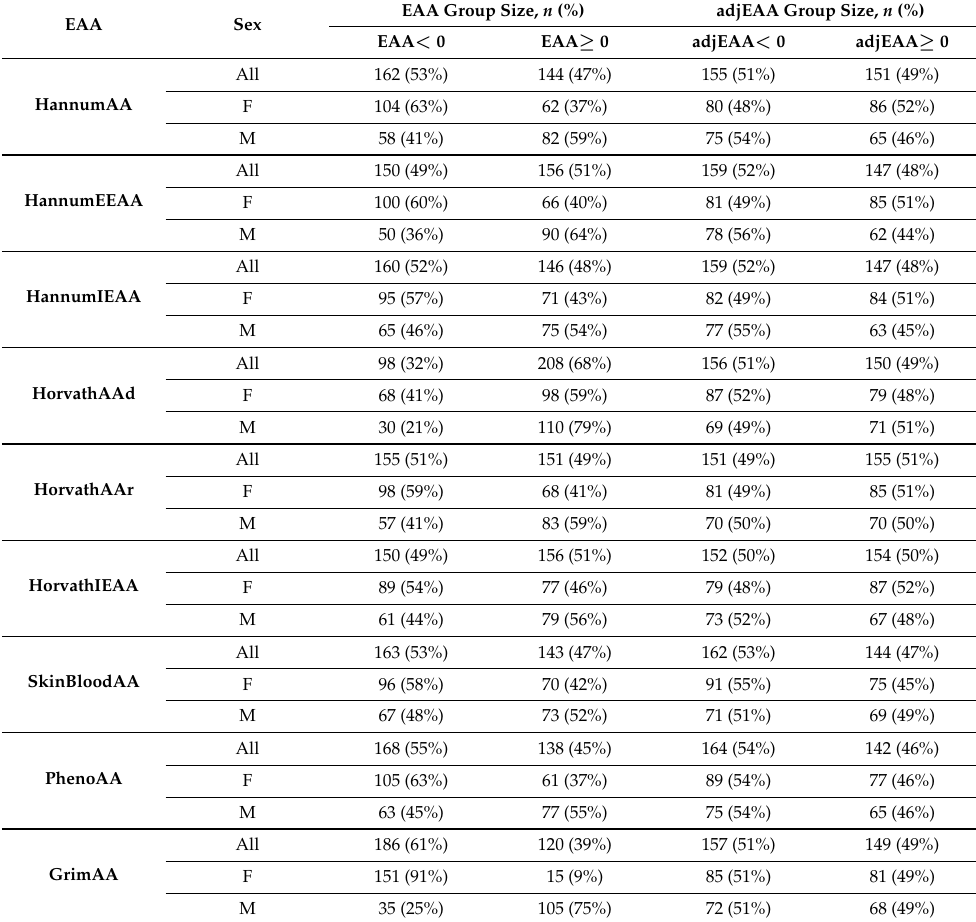
Table A4. Number of samples in EAA − and EAA + groups for unadjusted and adjusted for sex EAA